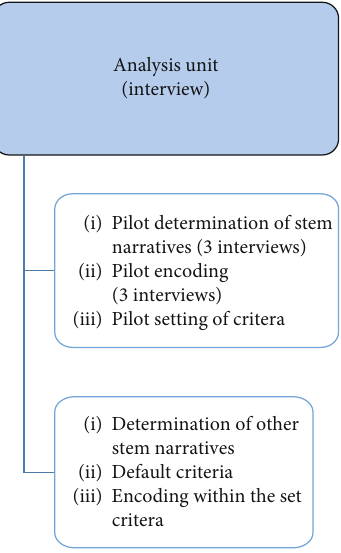
Figure 1: Analysis